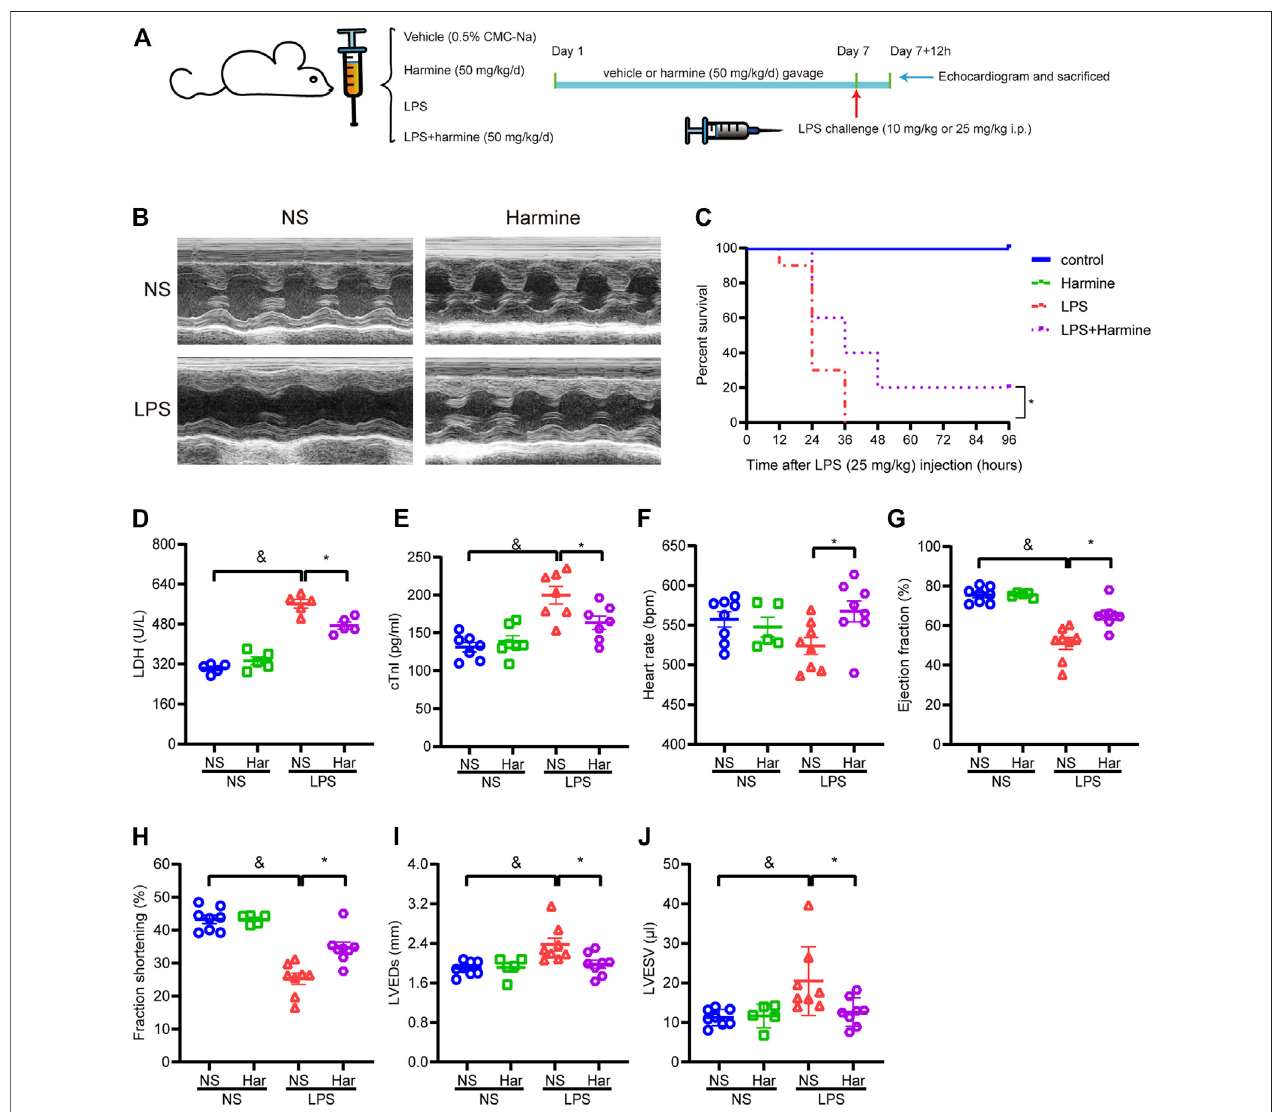
FIGURE 4 | Harmine mitigated sepsis-induced cardiac dysfunction and increased survival. (A) Diagram of the animal experiment. Harmine (50 mg/kg) or an equal volume of a 0.5% CMC-Na solution was administered to mice daily for seven consecutive days. At the end of Day 7 and 1 h after the gavage of harmine or vehicle, mice wereintraperitoneally injected with LPS (10 mg/kg)or an equal amount of normal saline (NS). After 12 h, the mice underwent echocardiograms and werethen sacri fi ced forfurtherexperiments. (B) RepresentativeimagesofM-modeechocardiogramsfrommice.NS (cid:1) normalsaline. (C) SurvivalofmiceafterLPS(25 mg/kg)orvehicle injection. Mouse survival was recorded every 12 h up to 96 h (D,E) Plasma levels of LDH ( n (cid:1) 5) and cTnI ( n (cid:1) 7). (F) Heart rate, (G) ejection fraction (EF), (H) fractional shortening (FS), (I) left ventricular end-systolic diameter (LVEDs), and (J) left ventricular end-systolic volume (LVESV). [ (F – J) , n (cid:1) 5 mice in the harmine group and n (cid:1) 8 mice in the remaining groups]. Data are presented as the means ± SEM, & p < 0.05 compared with the control group; * p < 0.05 compared with the LPS group.